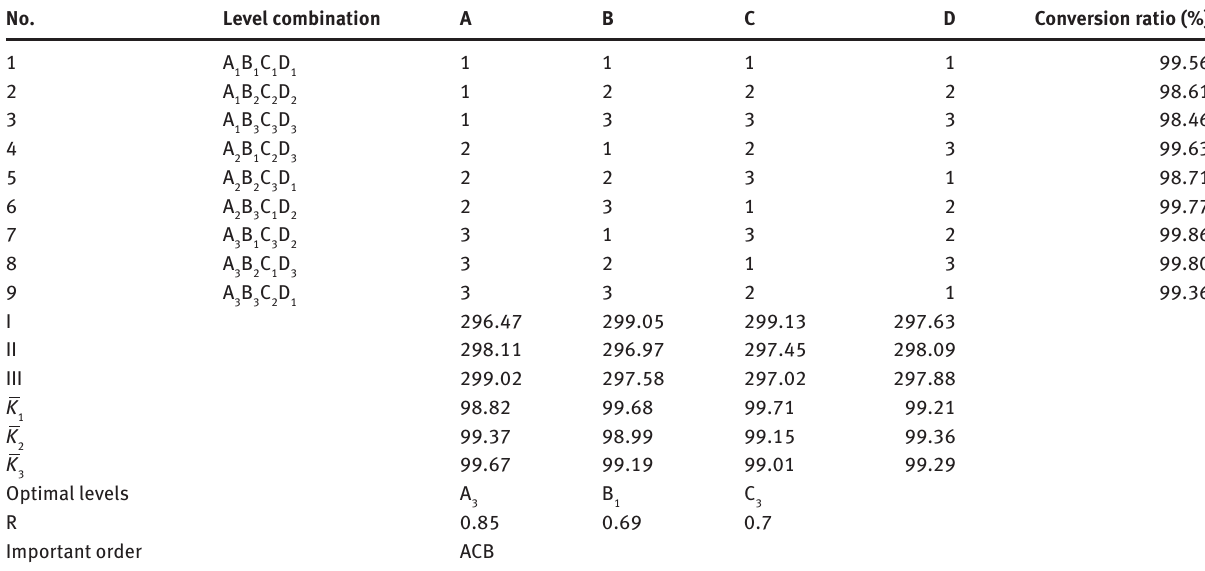
Table 3: Alumina conversion ratios and the range analyses results under different conditions. No.